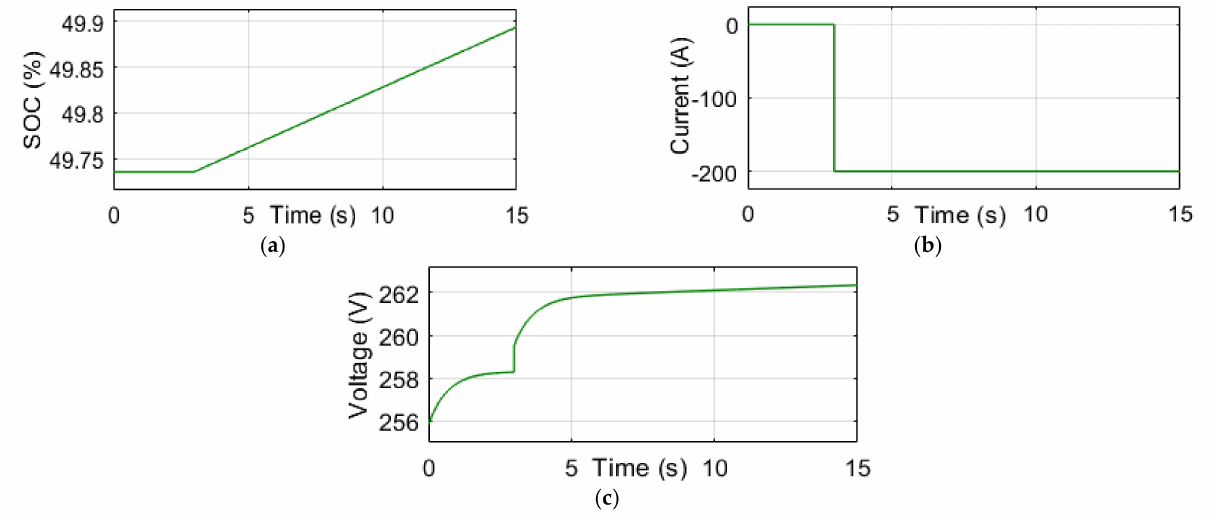
Figure 13. ( a ) BESS SOC condition, ( b ) BESS current condition and, ( c ) BESS voltage condition, where the BESS is